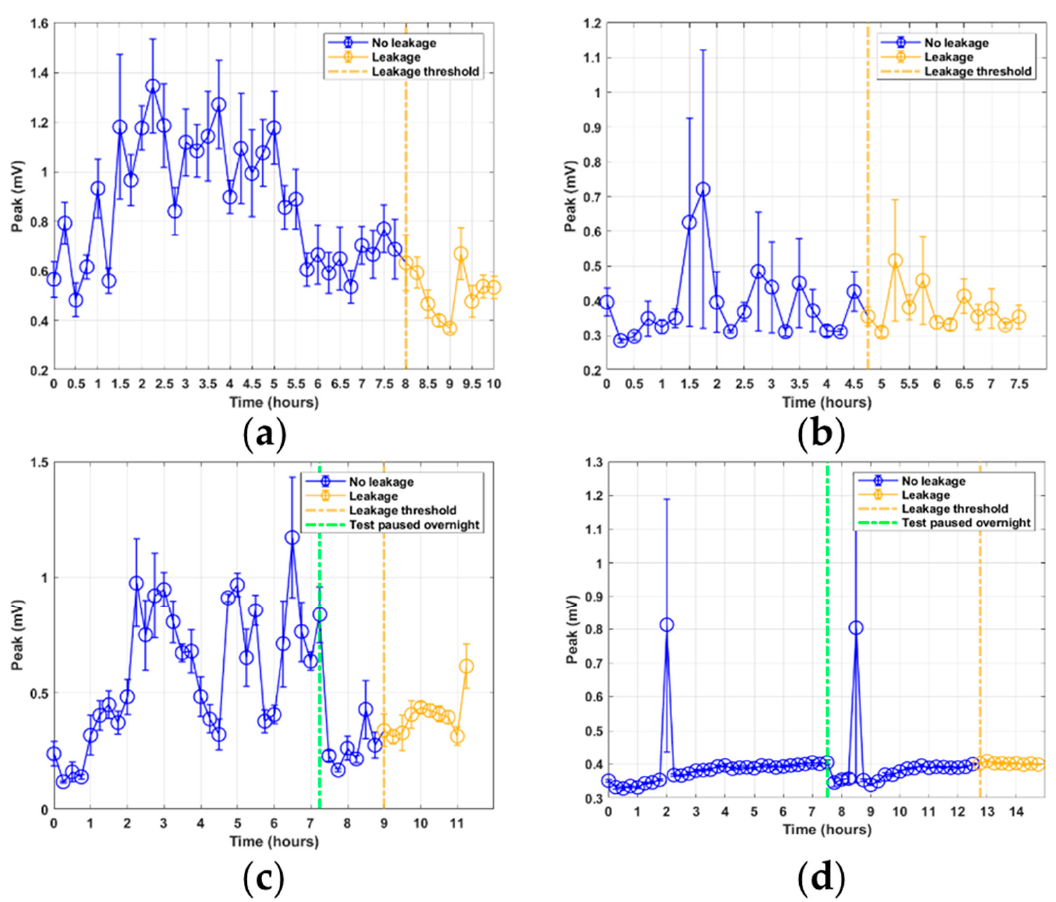
Figure 6. Peak feature results from RTF tests 1–4: ( a ) test 1; ( b ) test 2; ( c ) test 3; ( d ) test 4.